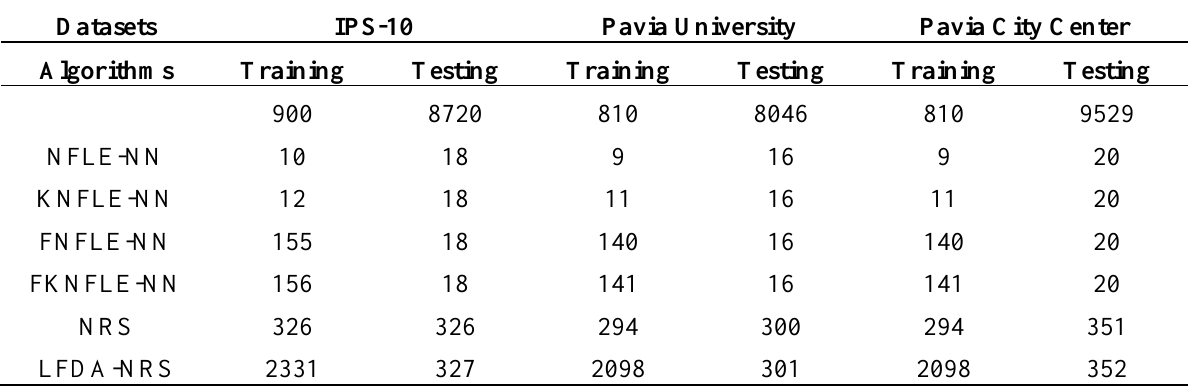
Table 2. The training and testing times of various algorithms for the benchmark datasets